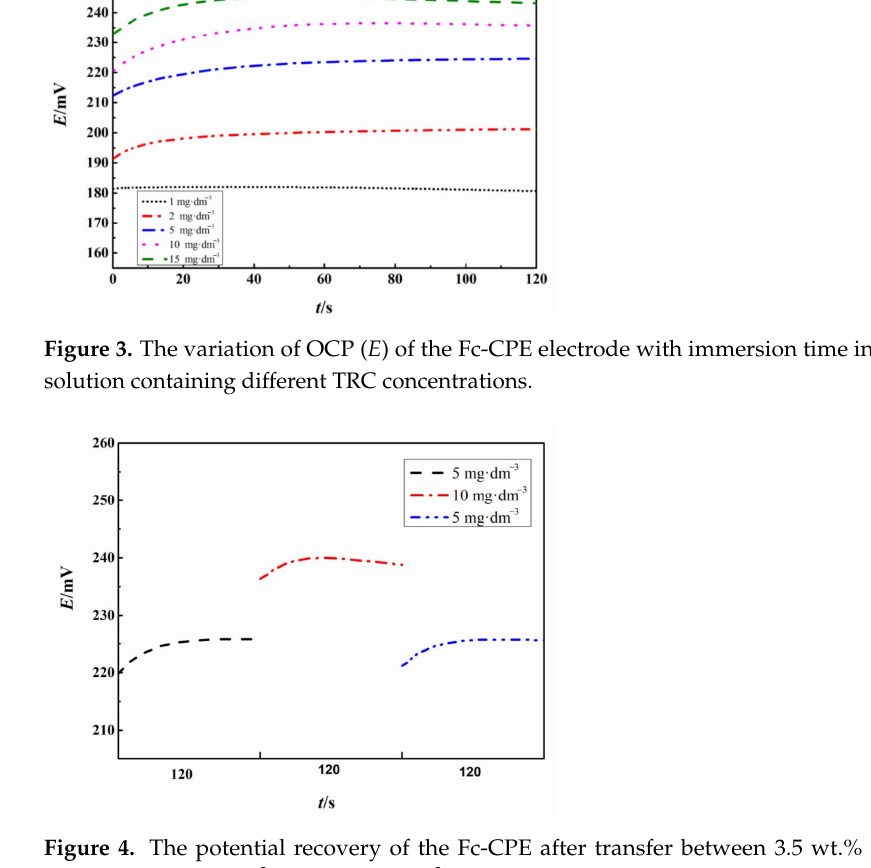
Figure 4. The potential recovery of the Fc-CPE after transfer between 3.5 wt.% NaCl solutions containing 5 mg · dm − 3 and 10 mg · dm − 3